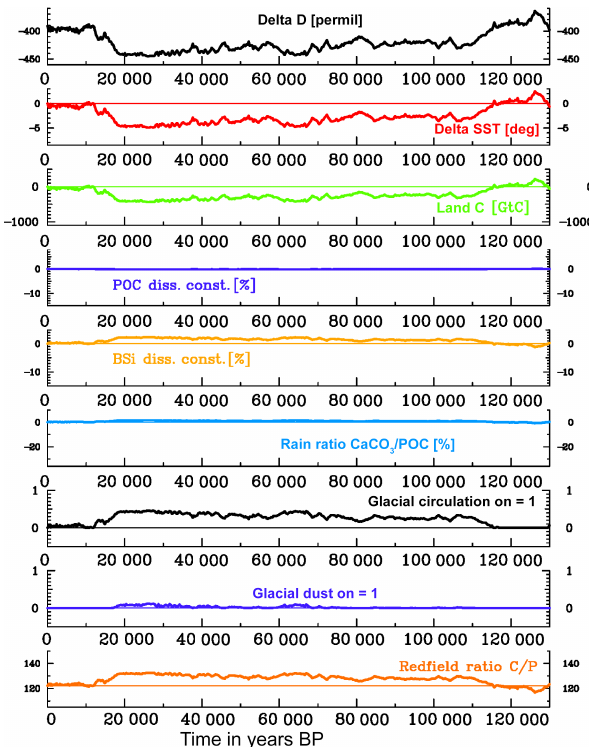
Figure 7. Resulting parameter variations in the past climatic cycle for the rank 7 solution of the linear response model.